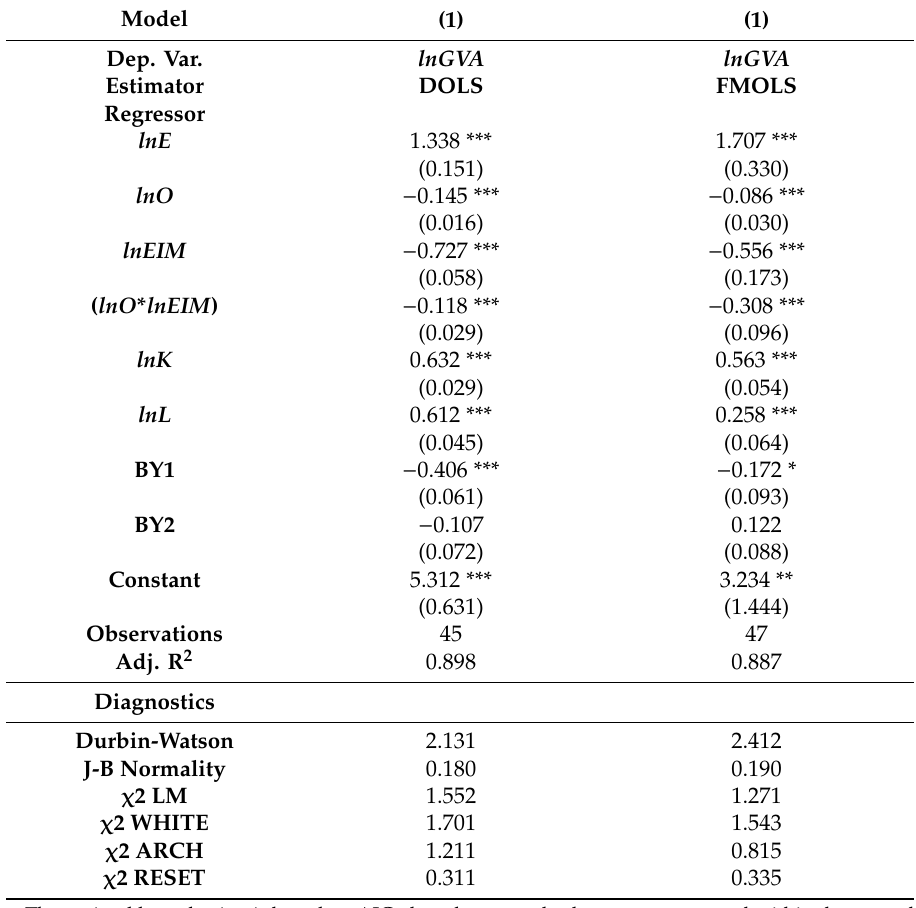
Table 5. The long-run elasticity estimates in the context of model